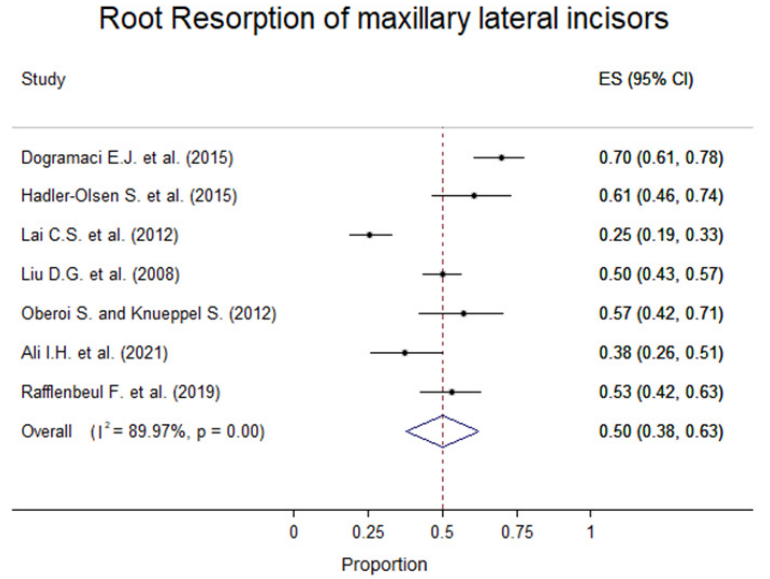
Figure 2. Forest plot with the prevalence of root resorption on patients with impacted canine [26– 32].